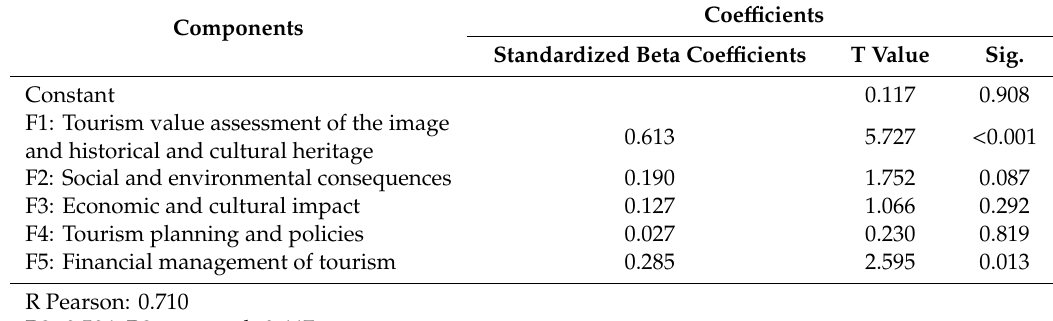
Table 7. Regression analysis. Linear regression based on factor scores Source: Author (cid:48) s